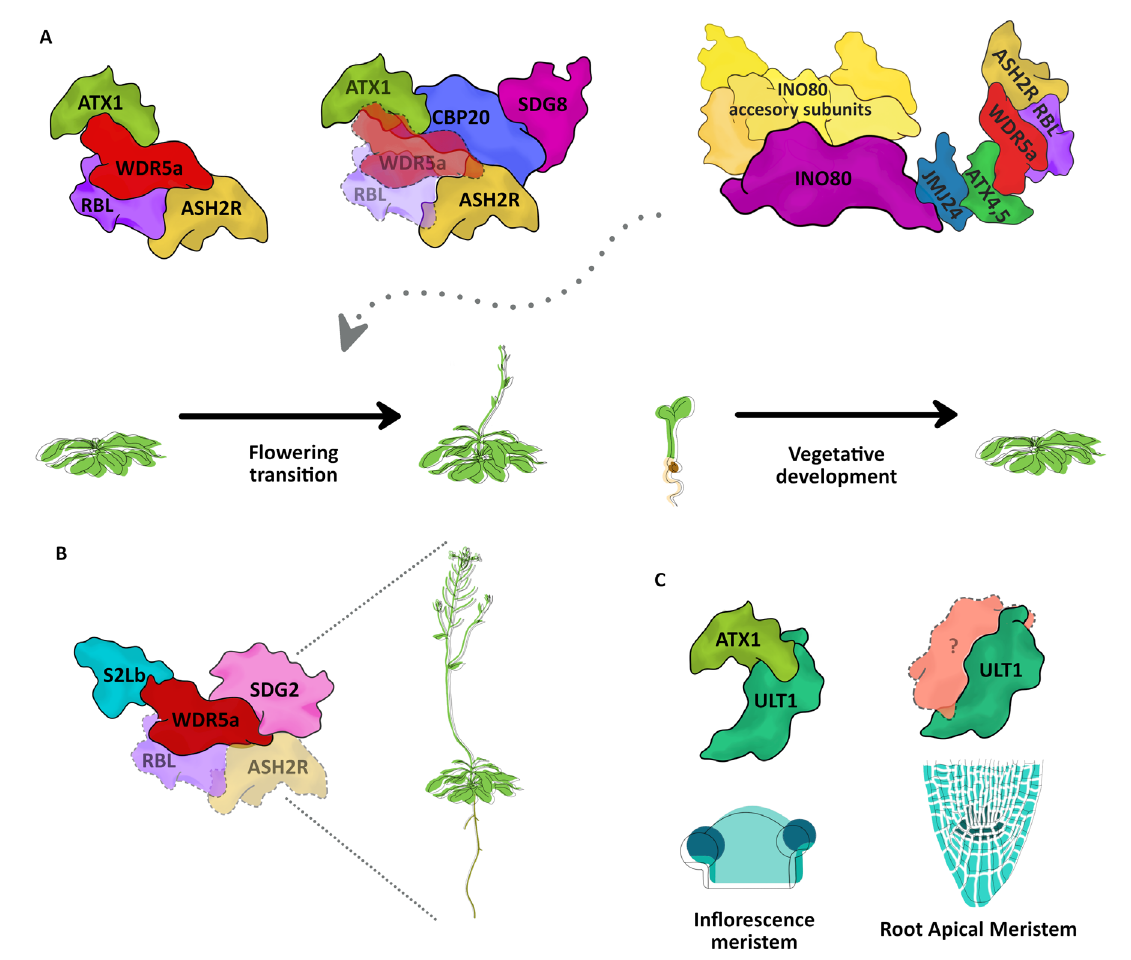
Figure 2. TrxG complexes reported in Arabidopsis. ( A ) The COMPASS-like complex formed by the core proteins WDR5a, RBL, and ASH2R interacts with ATX1 to control the flowering transition. SDG8 forms a complex with CBP20 which also interacts with ATX1 and ASH2R to regulate flowering transition. The chromatin remodeler complex INO80 interacts with the histone demethylase JMJ24, which in turn interacts with the ATX4 or ATX5 COMPASS-like complex to regulate the vegetative growth and the flowering transition (indicated by a dotted arrow). ( B ) The complex formed by the COMPASS protein WDR5a, which interacts with S2Lb and SDG2, regulates multiple processes in development, including root, vegetative, and reproductive processes. ( C ) ATX1 and ULT1 interact to form a complex that regulates the differentiation of inflorescence meristem, whereas, in the root, ULT1 regulates the maintenance of the root apical meristem independently of ATX1. Dotted proteins represent predicted interactions based on experimental